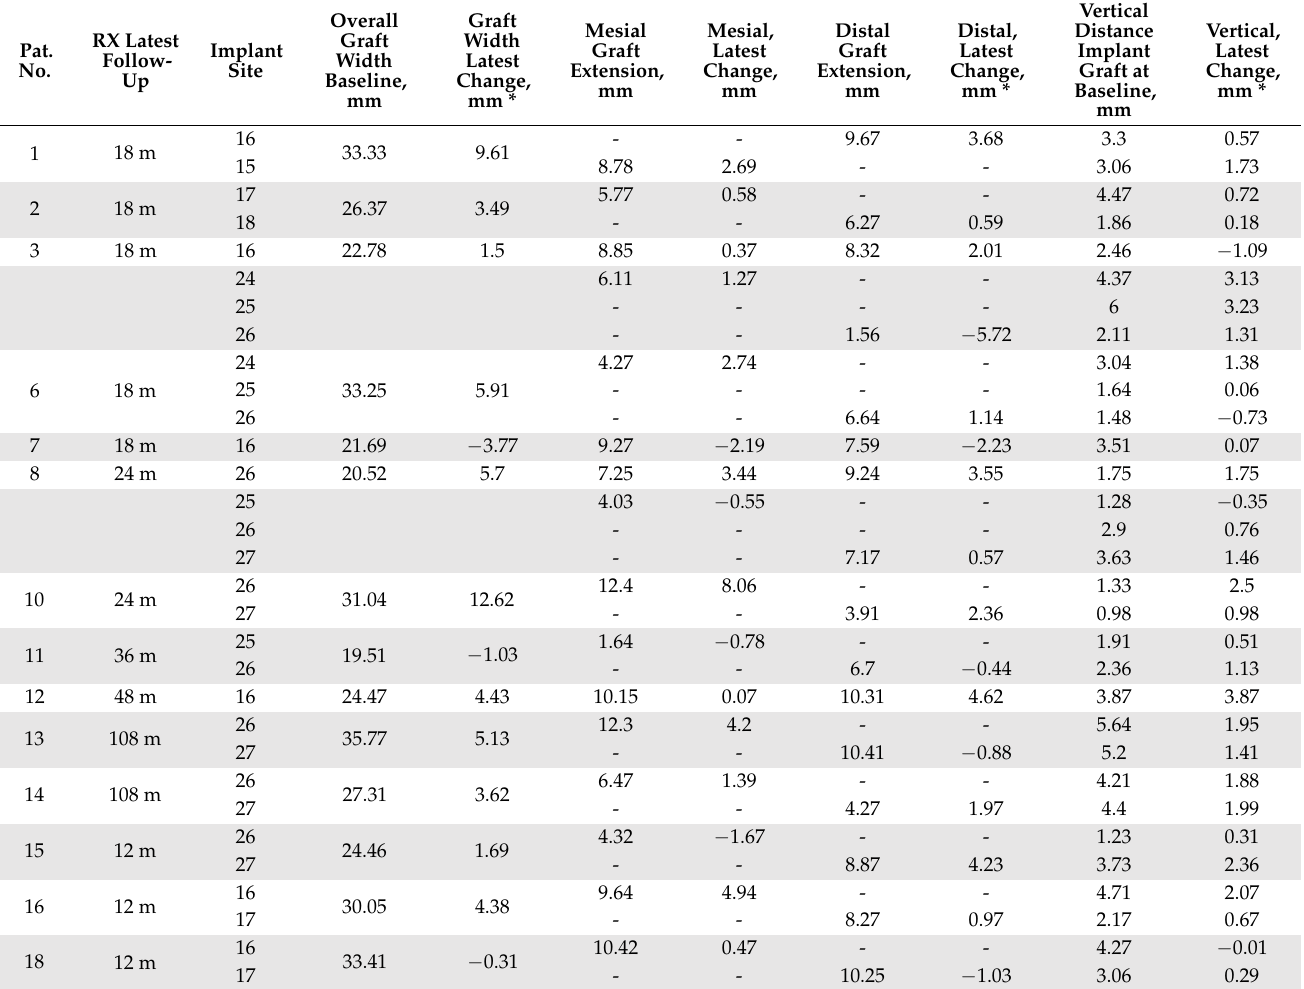
Table 2. Results of the dimensional evaluations for 16 patients. Data are expressed in